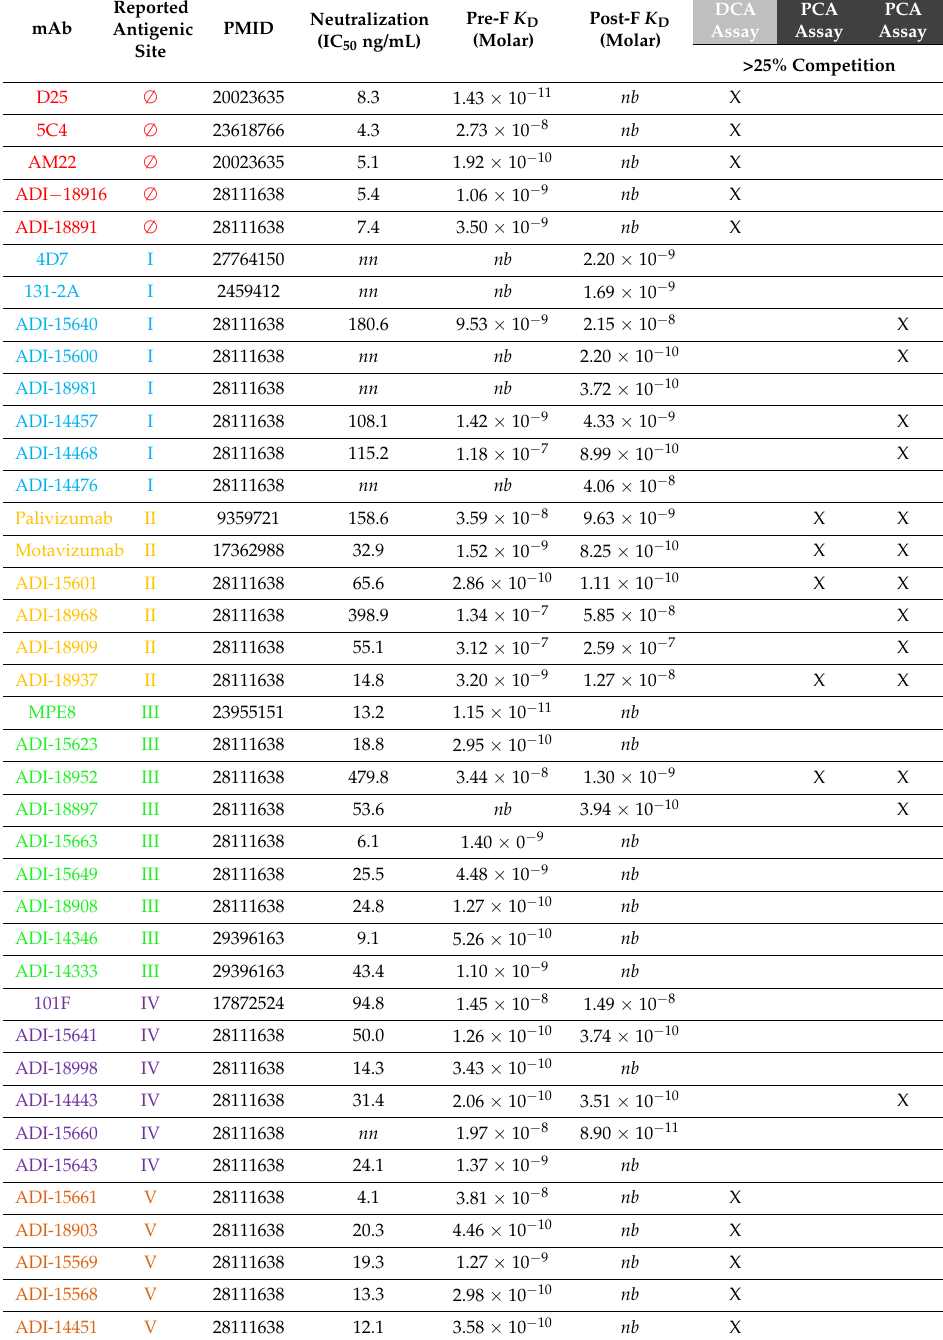
Table 1. Neutralization and K D profile of monoclonal